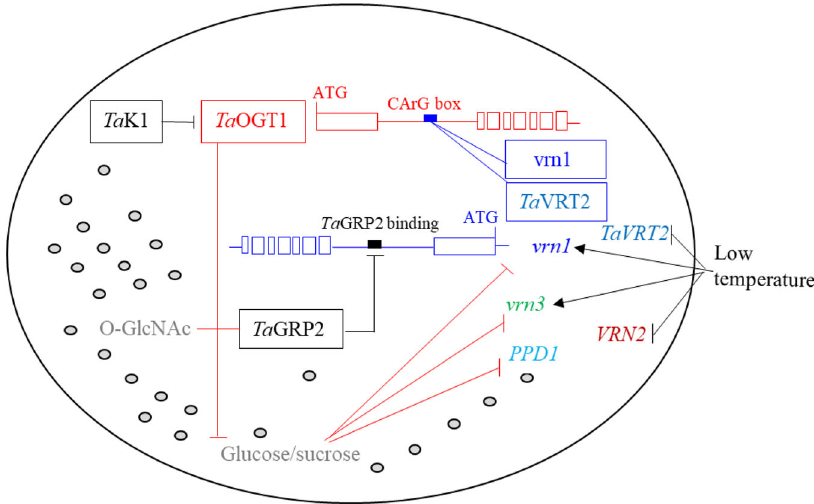
Fig. 7 A model for the regulation of heading date by the Ta OGT1-sugar pathway in winter wheat. Arrows indicate promotion and “ − | ” indicates repression. The genotypes of the winter wheat cultivars Billings and Duster contain recessive vrn1 and vrn3 alleles and a photoperiod-insensitive allele, PPD1 . Italic names indicate genes, and non-italic names indicate proteins. Shaded gray circles represent the cytoplasmic